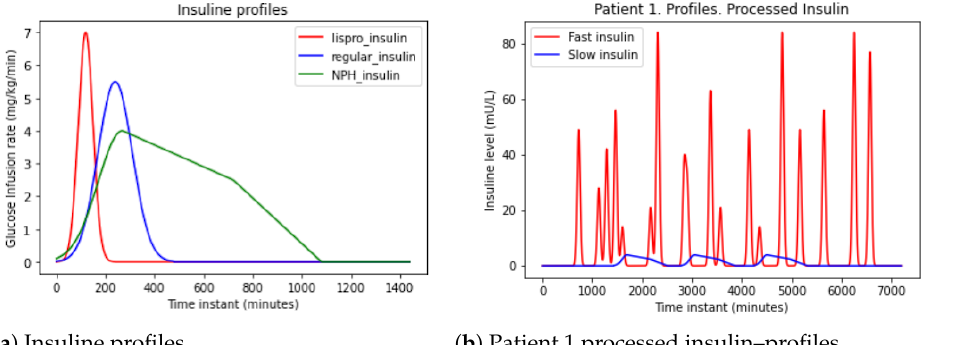
Figure 5. Patient 1 insulin data